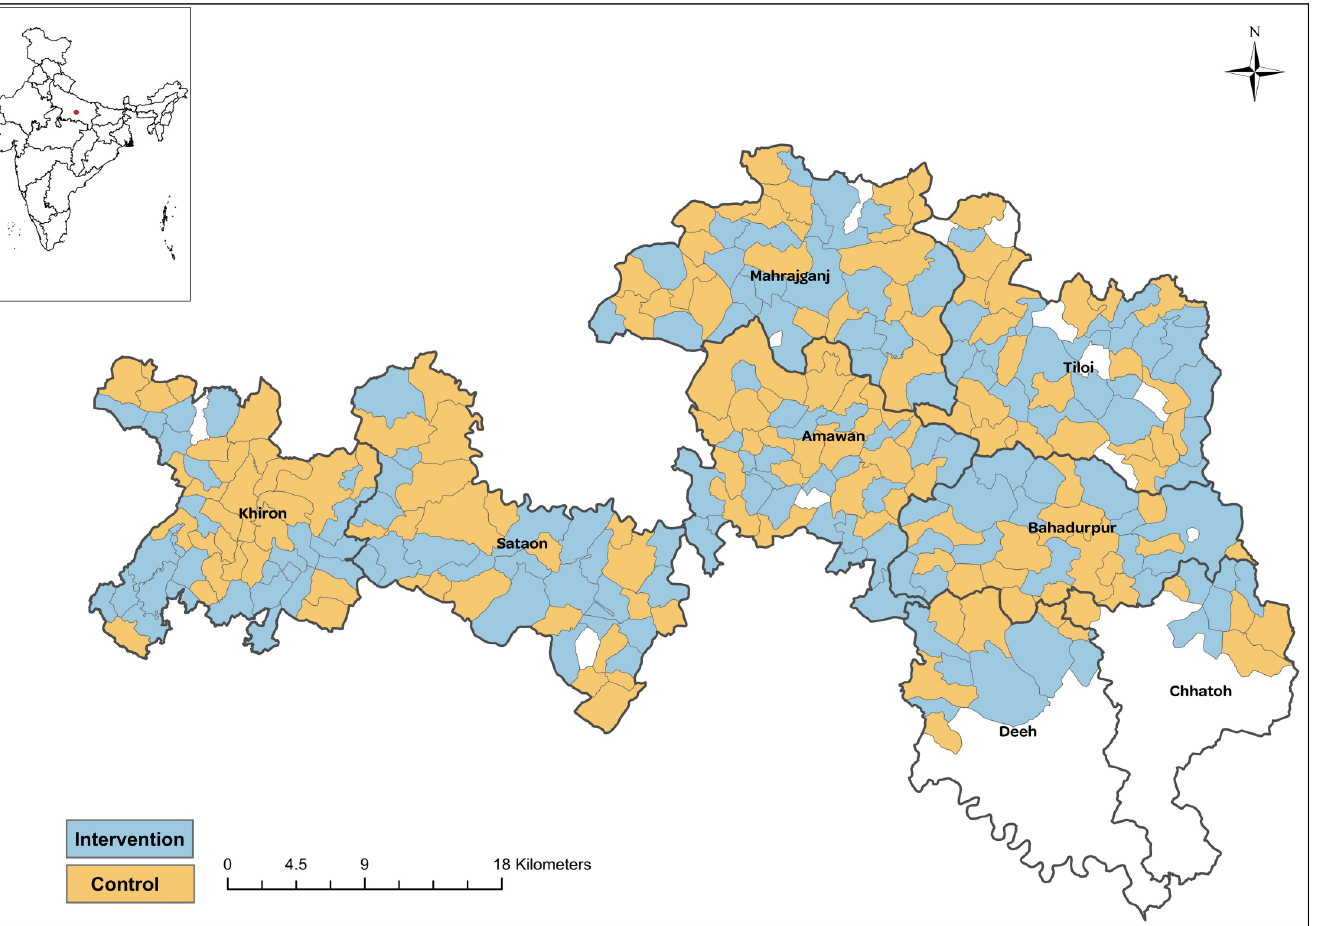
Fig 1. Trial location in Raebareli district, Uttar Pradesh, India, showing the randomized allocation of intervention and comparison clusters across study blocks. The base map was created at the Community Empowerment Lab using publicly available data.